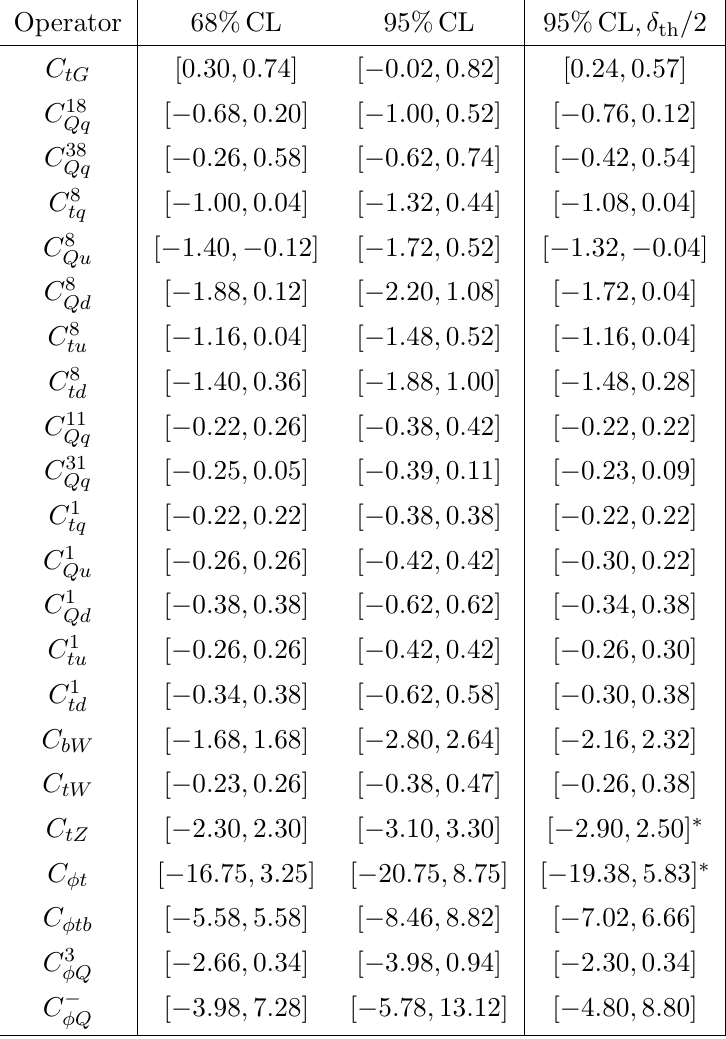
Table 9 . Bounds on the Wilson coe(cid:14)cients C i in units of (TeV = (cid:3)) 2 at 68% and 95% con(cid:12)dence level from our full global top (cid:12)t, corresponding to (cid:12)gure 13. The asterisk marks non-Gaussian e(cid:11)ects for which we quote conservative envelopes of the likelihood. The label (cid:14) th = 2 stands for the (cid:12)t with halved theoretical